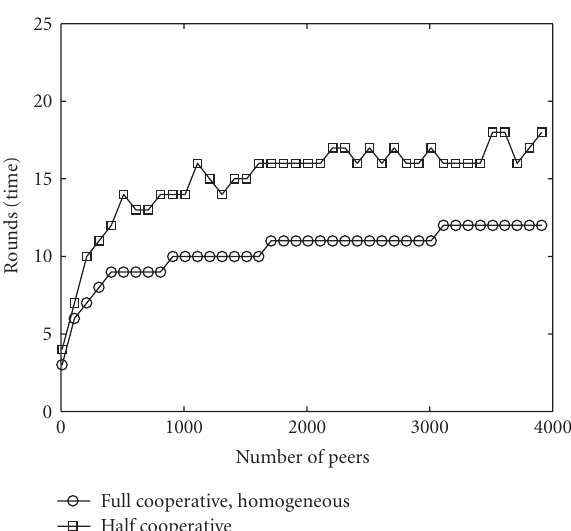
Figure 2: A stream block reaches all n peers in O (log n ) time with the peer-wise proportional fairness incentive mechanism.